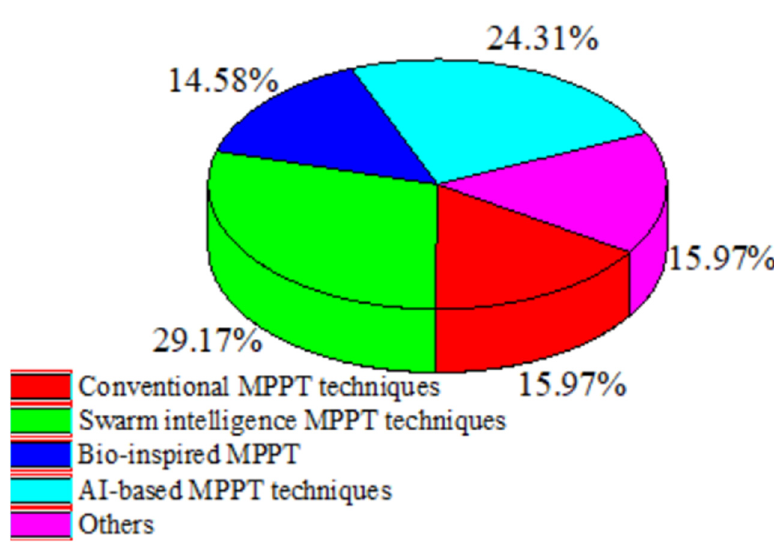
Figure 24. Papers focused on different MPPT techniques .